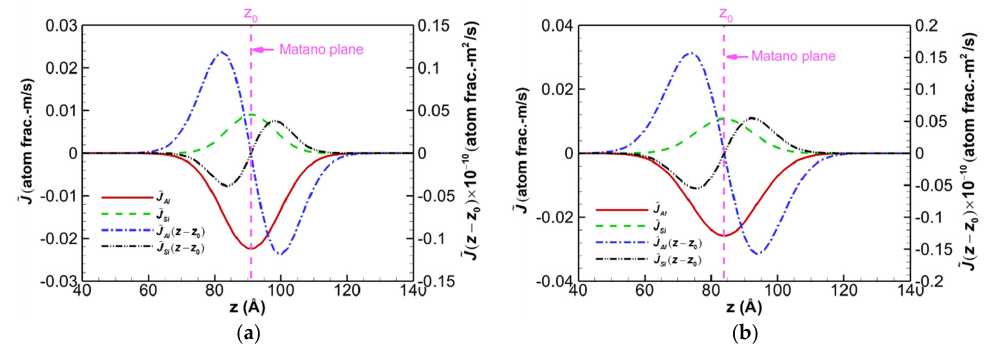
 J ( ) J z z for diffusion couples of the C − termi- Figure 9. Profiles of the interdiffusion flux and  − Figure 9. Profiles of the interdiffusion flux (cid:101) J and (cid:101) J ( z − z 0 ) for diffusion couples of the C − terminated 0 nated ( a ) 6H − SiC/Al and ( b ) 3C − SiC/Al annealed at 2000 K for 6 ns. ( a ) 6H − SiC/Al and ( b ) 3C − SiC/Al annealed at 2000 K for 6